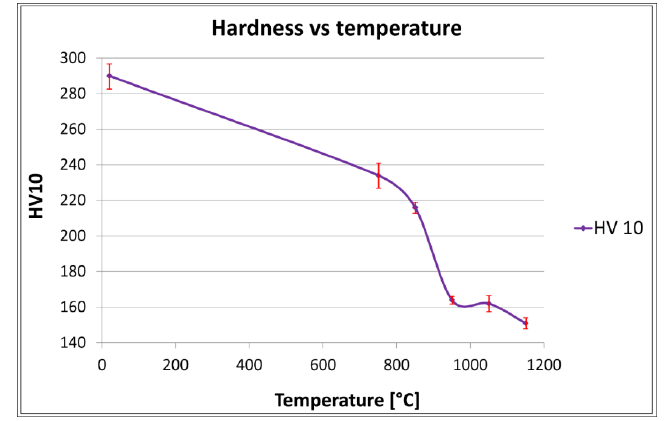
Figure 9. Dependence of MoNiCr hardness on annealing temperature. Table 4. Hardness values HV10—recrystallization